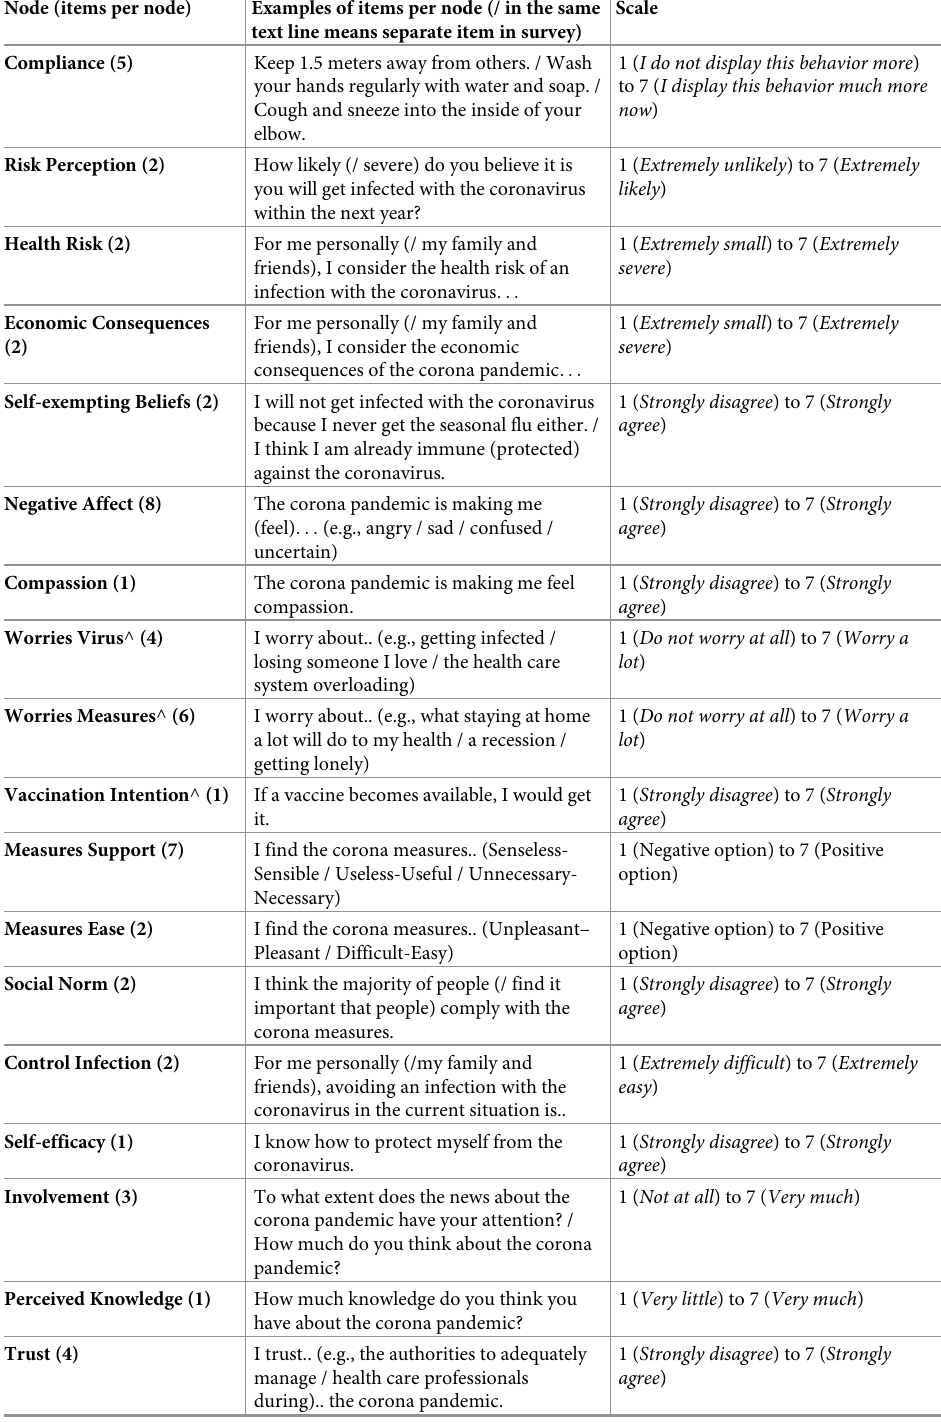
Table 2. Nodes (psychological variables) based on items in the survey, including item examples and answer